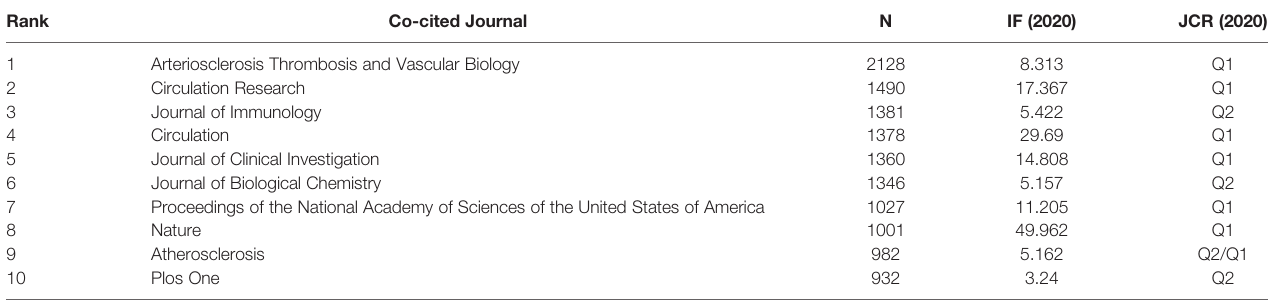
TABLE 4 | The top 10 co-cited journals of macrophage polarization in AS research.